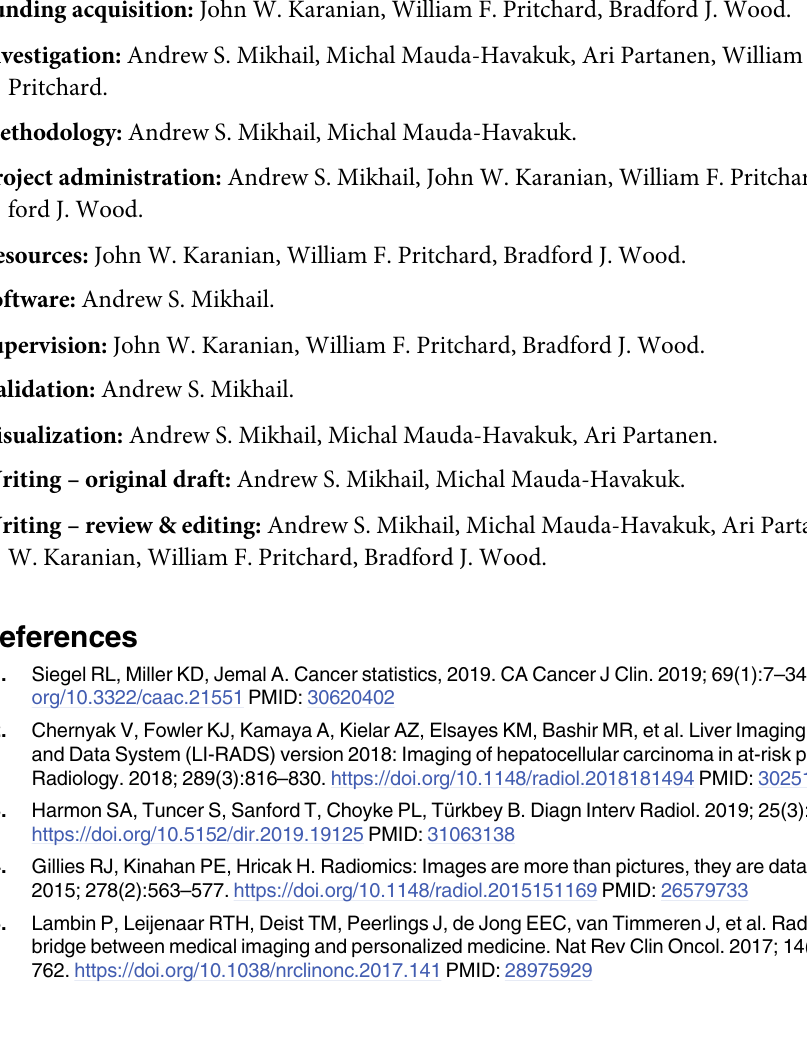
S1 Table. Dice similarity coefficients (DSC) demonstrating the spatial overlap of histopa- thology sections and corresponding image slices using liver-specific 3D